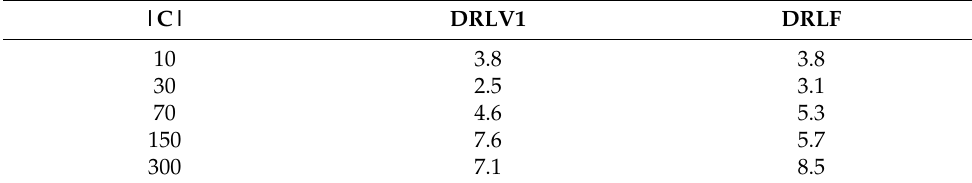
Table 3. Percentage of not accepted ODs.